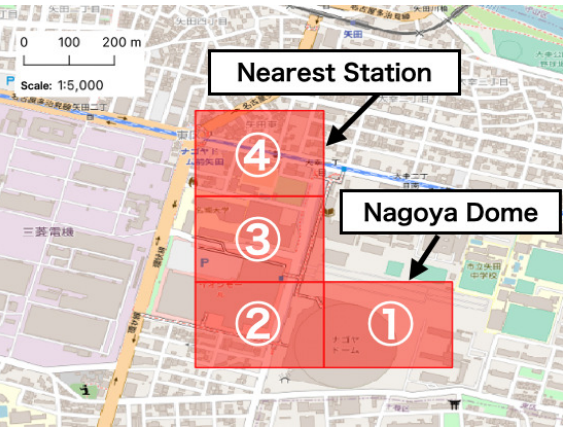
Figure 3. Four zones chosen for basic analysis near the event site (No. 1 includes the event site, Nagoya Dome, and No. 4 includes the nearest station to the event site).